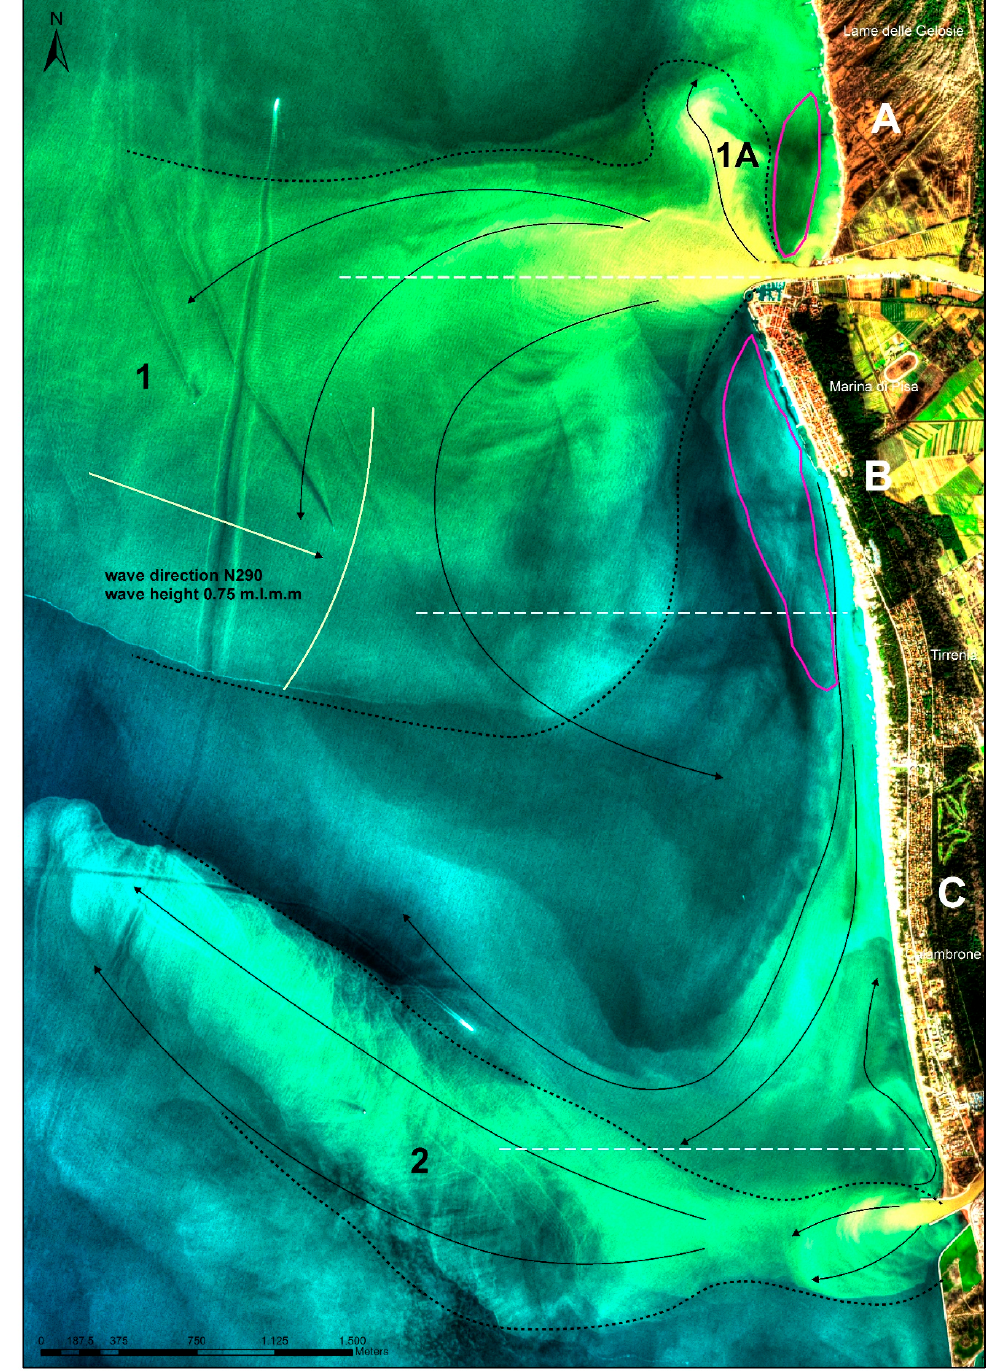
Figure 7. Sentinel-2 image of 6 February 2019 showing the end of the Arno flood event of 3 February 2019 characterized by a fluvial discharge of 1131m 3 /s at the S. Giovanni alla Vena gauge and wave direction N 290. A, B and C indicate specific coastal stretches to which reference has been made in the text. Black arrows show the sediment flow directions reconstructed after qualitative analysis of the image using the tone mapping method to emphasize the contrast. Dashed lines highlight the main plumes at the different river mouths. Purple lines enclose the shadow